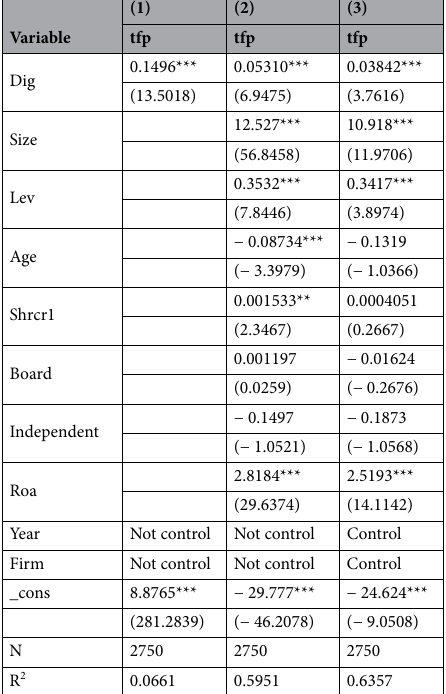
Table 4. Impact of digitization on total factor productivity of firms. T-statistics are shown in parentheses. ***, ** indicate 1%, 5%